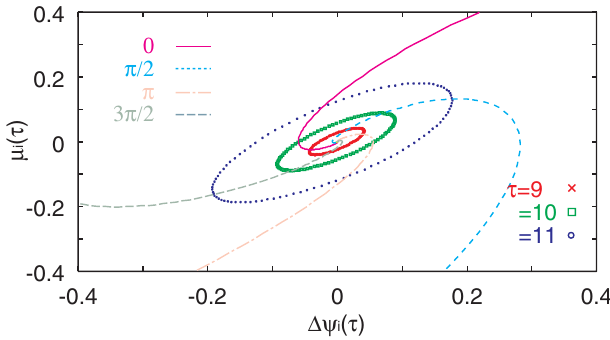
FIG. 7. (Color) Electron distributions of an electron microbunch (cid:2) 0 (cid:4) (cid:1) (cid:7) 1 : 7 in a phase plane of (cid:1) with (cid:8) i from a time-dependent simulation when (cid:6) (cid:1) 9 (solid line), 10 (dotted line), 11 (dash-dotted line). The simulation parameters are the same as in Fig.